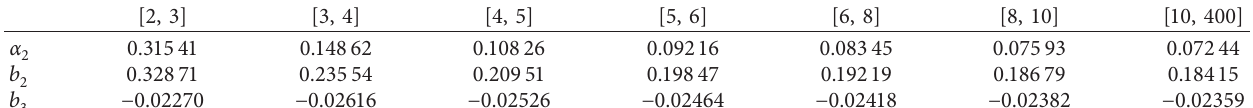
Table 1: Weight parameters for different intervals of. G